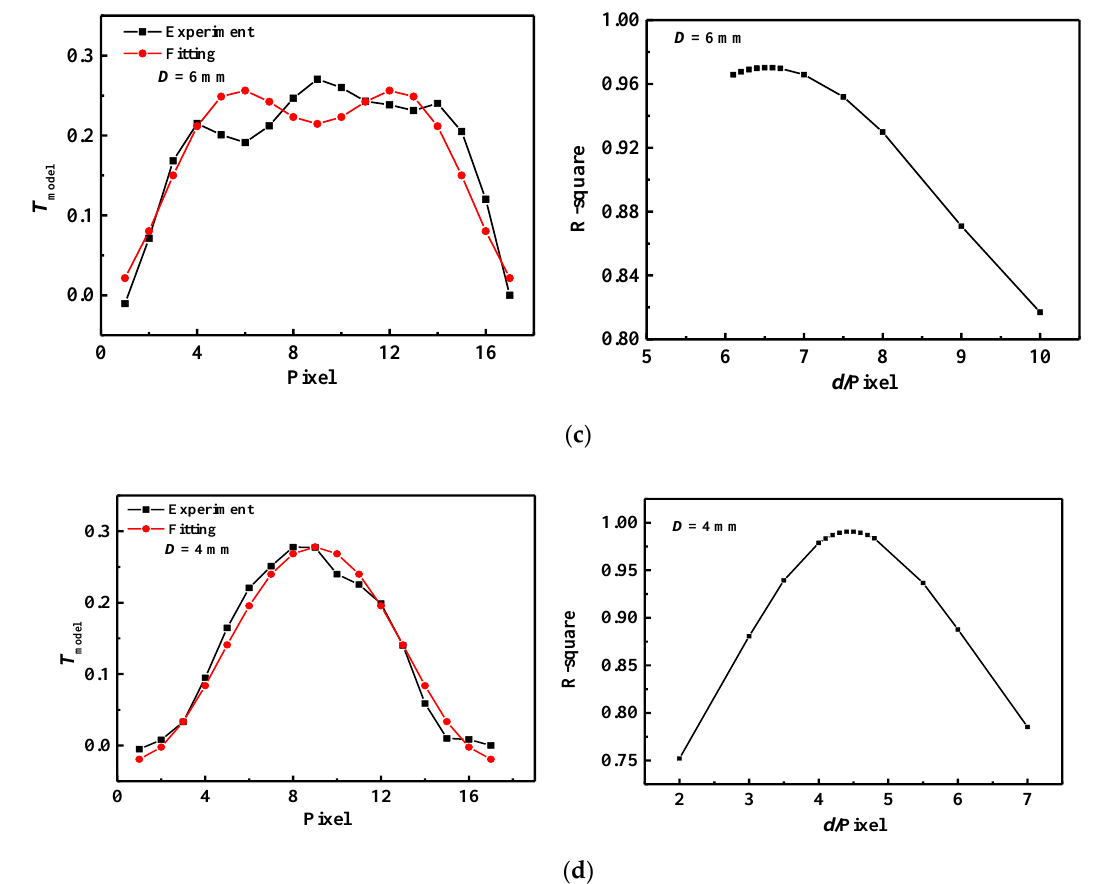
Figure 12. Temperature curve along the center of defect after background processing and fitted function curve with best degree of fitting (left). Degree of fitting of function curve vs. different value of d (right): ( a ) D = 10 mm; ( b ) D = 8 mm; ( c ) D = 6 mm and ( d ) D = 4 mm.